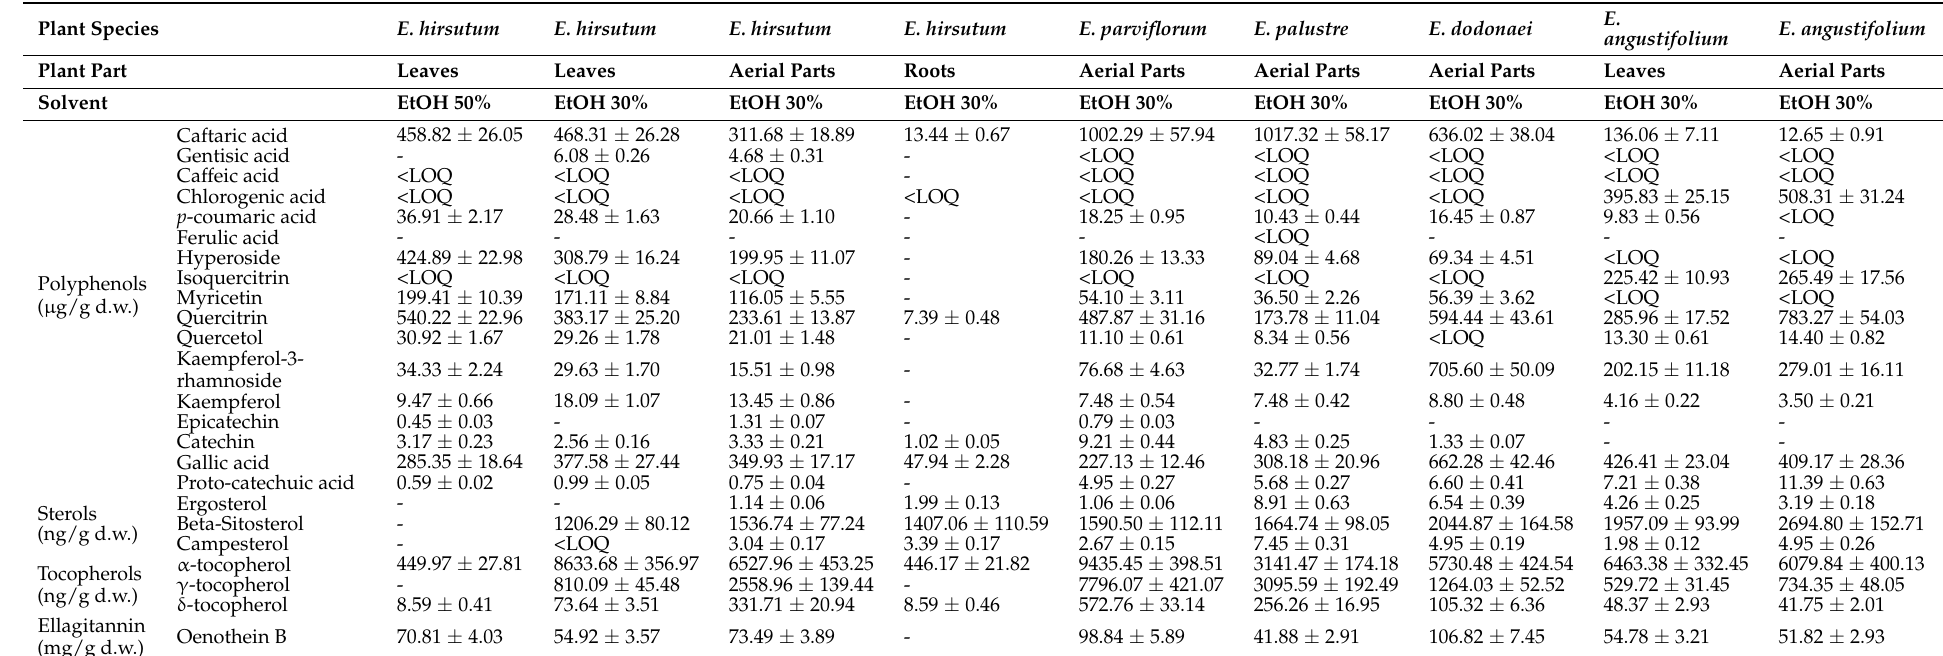
Table 6. Identification and Quantification of Bioactive Compounds by